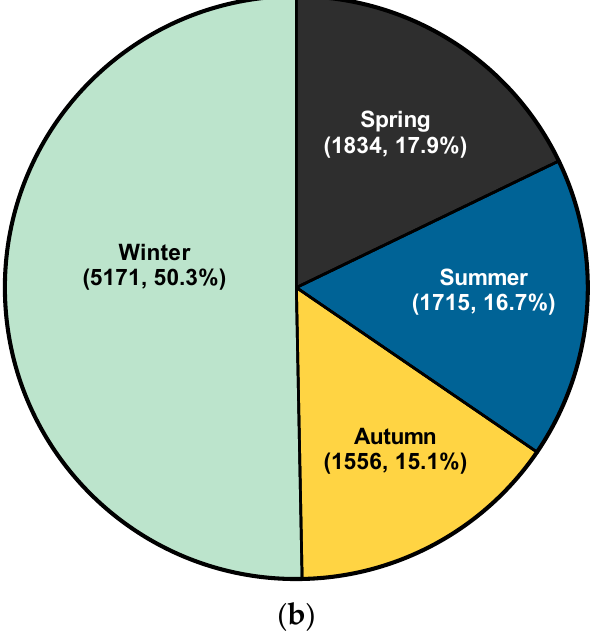
Figure 1. ( a ) Monthly trend analysis of encephalitis from 2015 to 2019. ( b ) Seasonal trend analysis of encephalitis incidence. Spring (March to May), summer (June to August), autumn (September to November), and winter (December to February). Cumulative incidence for 5 years, %. In addition, the seasonal trends in the incidence rate were similar in all age groups, increasing in the winter (Figure 2).